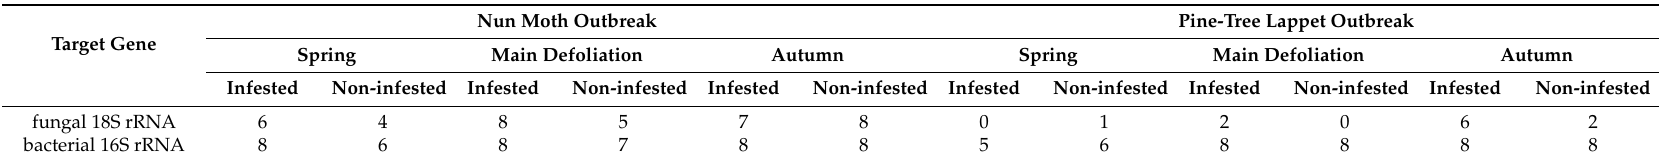
Table A6. Needle samples above the detection limit for fungal 18S and bacterial 16S rRNA gene abundance for the sampling dates in nun moth ( Lymantria monacha L.) and pine tree lappet ( Dendrolimus pini L.) infested and non-infested Scots pine ( Pinus sylvestris L.) forest